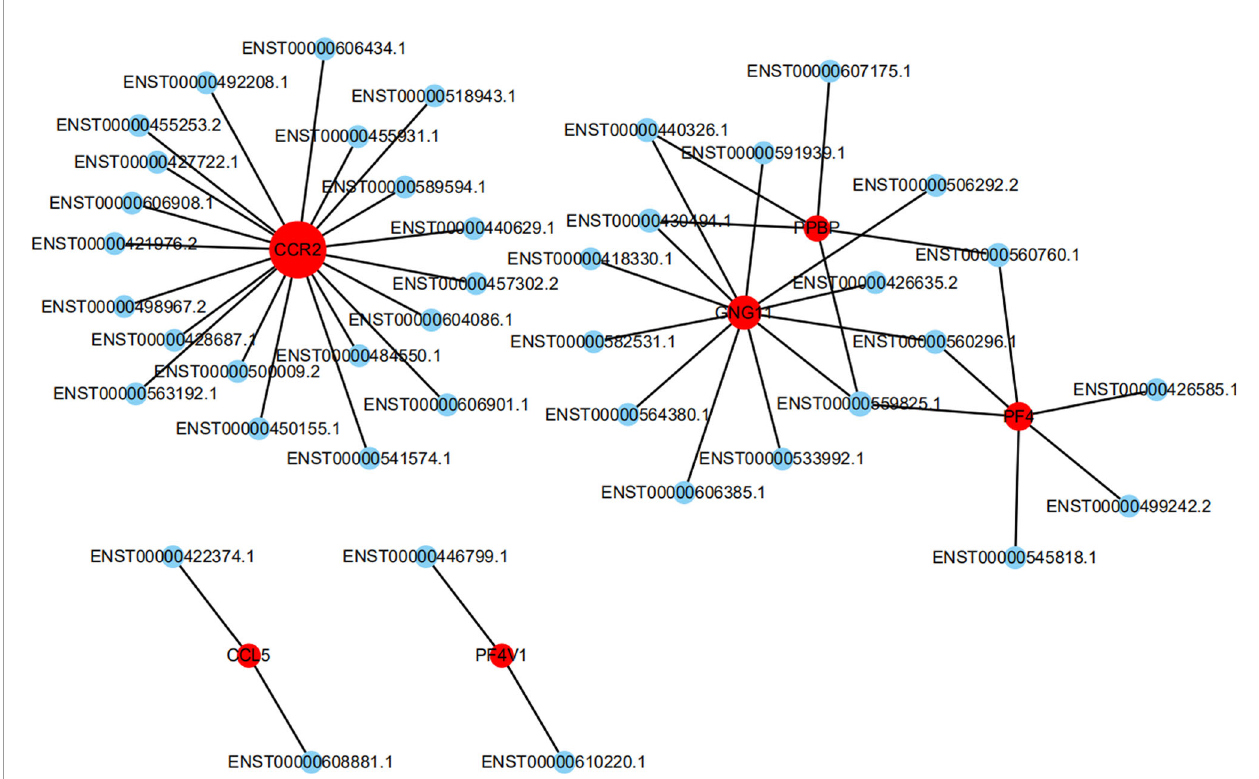
FIGURE 3 | The network represents the co-expression correlations between the signi fi cantly differentially expressed mRNA and lncRNA transcripts in the chemokine signaling pathway. Red circles indicate mRNA transcripts, and blue circles indicate lncRNA. Solid lines indicate